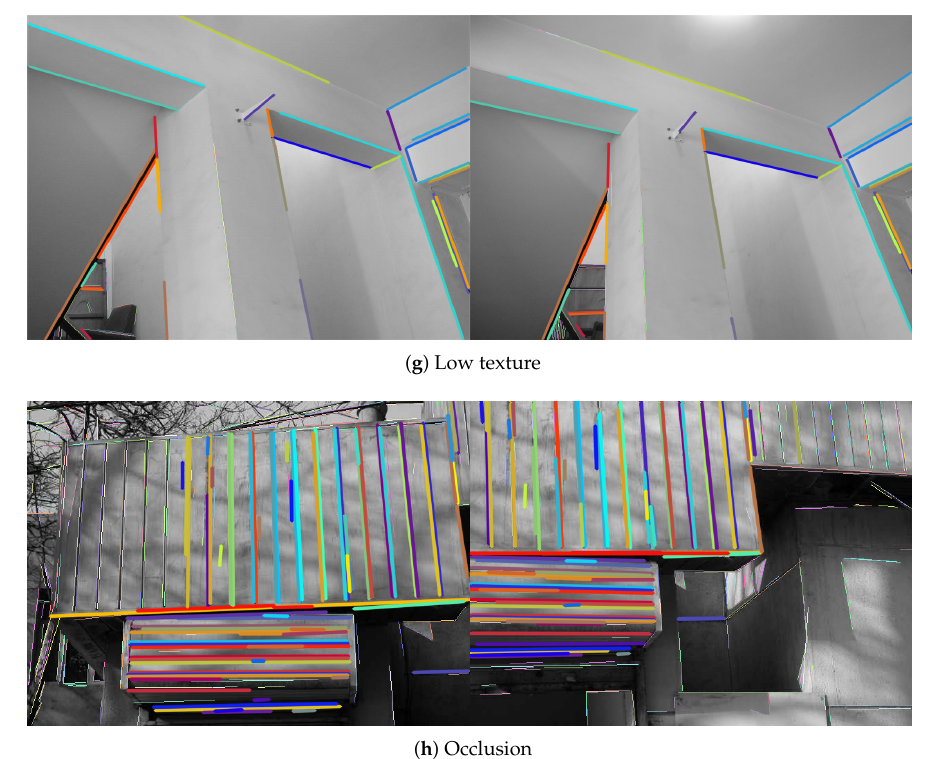
Figure 11. Lines of the same color in both figures represent matched lines. Those thin lines are extracted by EDLines but not successfully